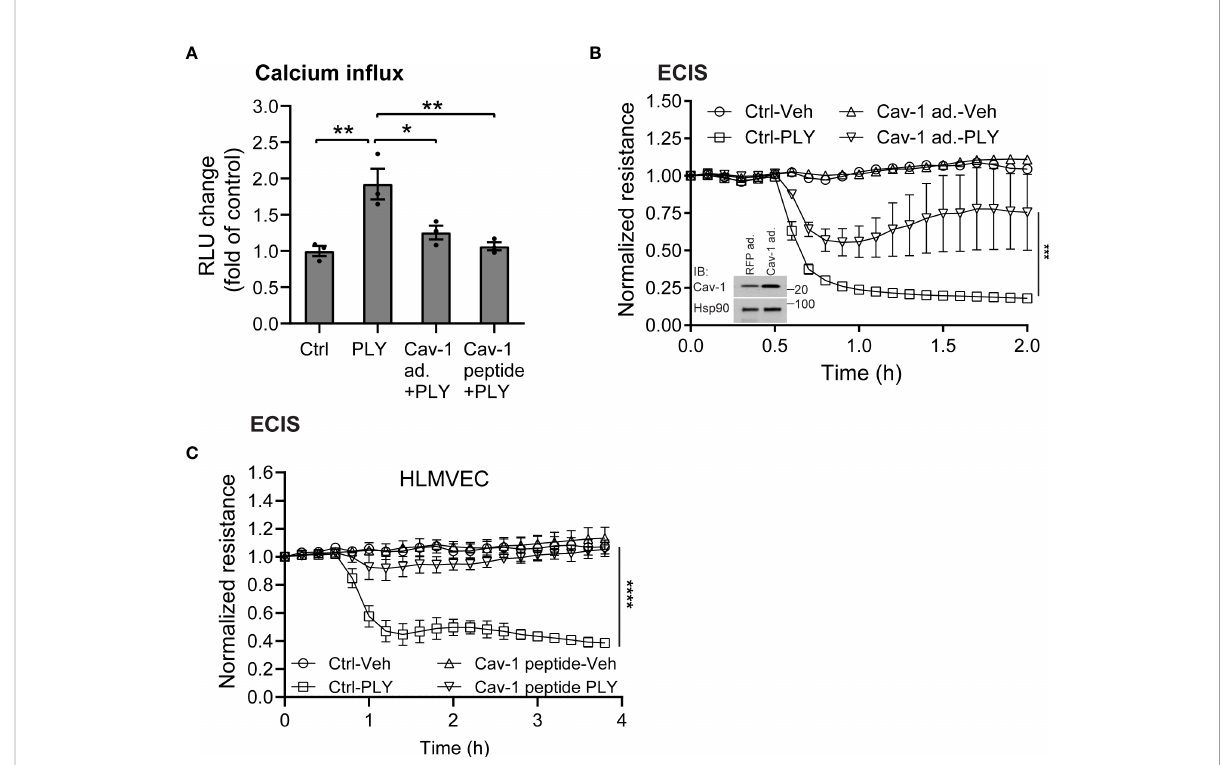
FIGURE 2 Caveolin-1 overexpression protects against Pneumolysin (PLY) induced calcium entry and endothelial barrier dysfunction. (A) Caveolin-1 overexpression or Cav-1 peptide blocks PLY induced Ca 2+ entry in Cos7 cells. Data are represented as mean ± SE (n=3-4), * P<0.05, **P<0.01 vs. vehicle control. (B) HLMVEC cells were transduced with 10-10 MOI RFP (RFP ad.) or caveolin-1 adenovirus (Cav-1 ad.) ( Inset : western blot analysis of Caveolin-1 overexpression. Hsp90 was used as loading control), or (C) treated with 10 m M caveolin-1 scaffolding domain peptide for 24 hours, and TER of vehicle or PLY (60ng/mL) treated HLMVECs was measured (n=3). ***P<0.001, ****P<0.0001. One-way ANOVA (with Tukey ’ s post-hoc